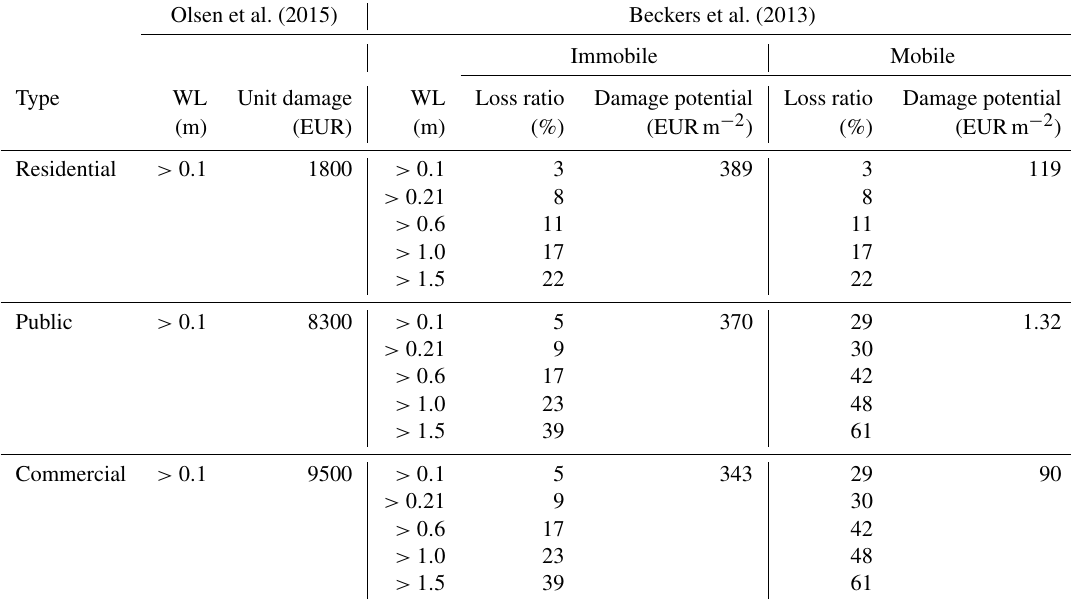
Table 1. Damage assessment frameworks considered in our work. WL is water level. Olsen et al. (2015) Beckers et al. (2013) Immobile Mobile Type Unit damage WL Loss ratio Damage potential Loss ratio Damage